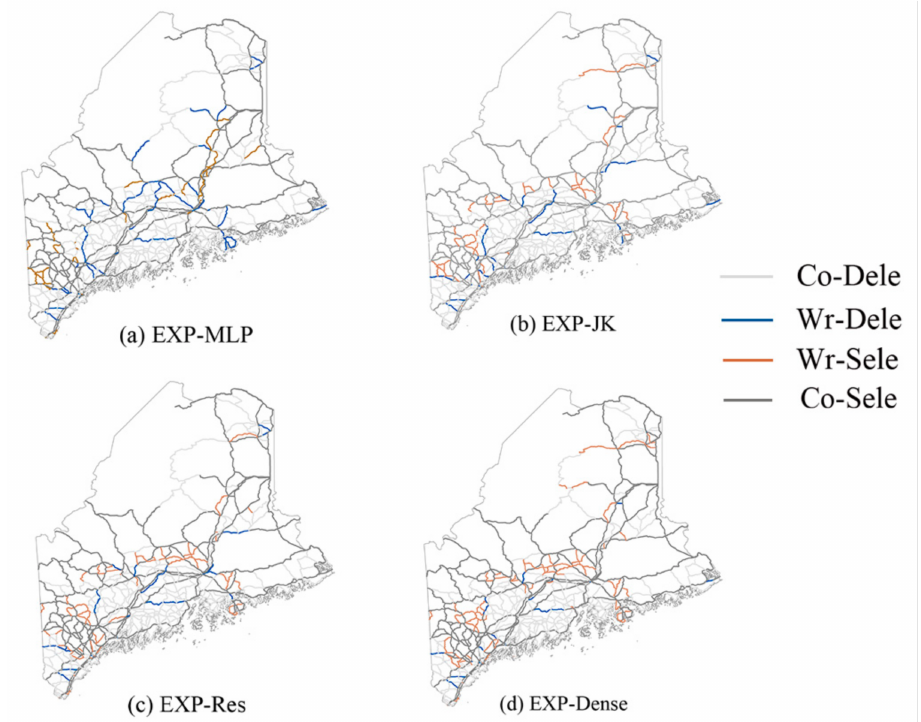
Figure 9. Combinations of the road network obtained using different models and the road network selected by experts: ( a ) expert and multilayer perceptron (EXP-MLP); ( b ) expert and JK-GAT (EXP-JK); ( c ) expert and Res-GAT (EXP-Res); and ( d ) expert and Dense-GAT (EXP-Dense). Co-Dele represents correctly deleted roads, Wr-Dele represents incorrectly deleted roads, Wr-Sele represents incorrectly selected roads, and Co-Sele represents correctly selected roads. The gray lines in the figure represent the correctly predicted road network; the light gray lines represent the unselected network, and the dark gray lines represent the selected network. The colored lines represent the inaccurately predicted roads; the orange lines represent the inaccurately selected roads, and the blue lines represent the incorrectly deleted